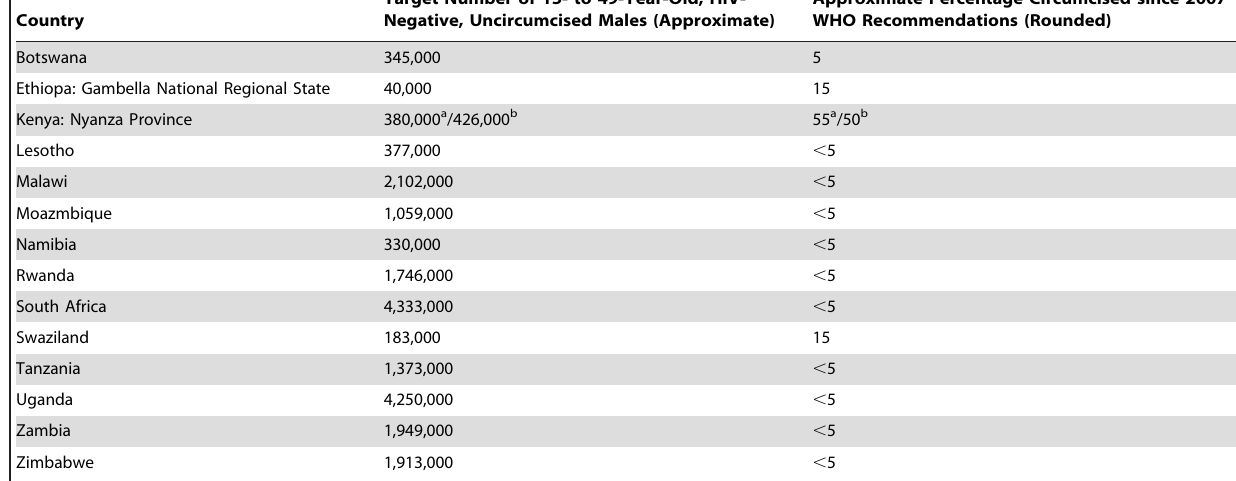
Table 1. Target number of HIV-negative males needed to be medically circumcised by 2015 to reach 80% coverage, and approximate proportion of those reached with medical MC services through late 2011.